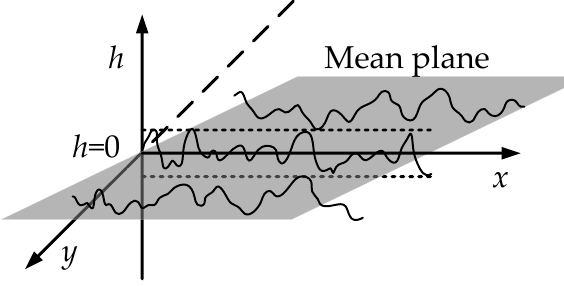
Figure 4. Schematic diagram of surface topography.